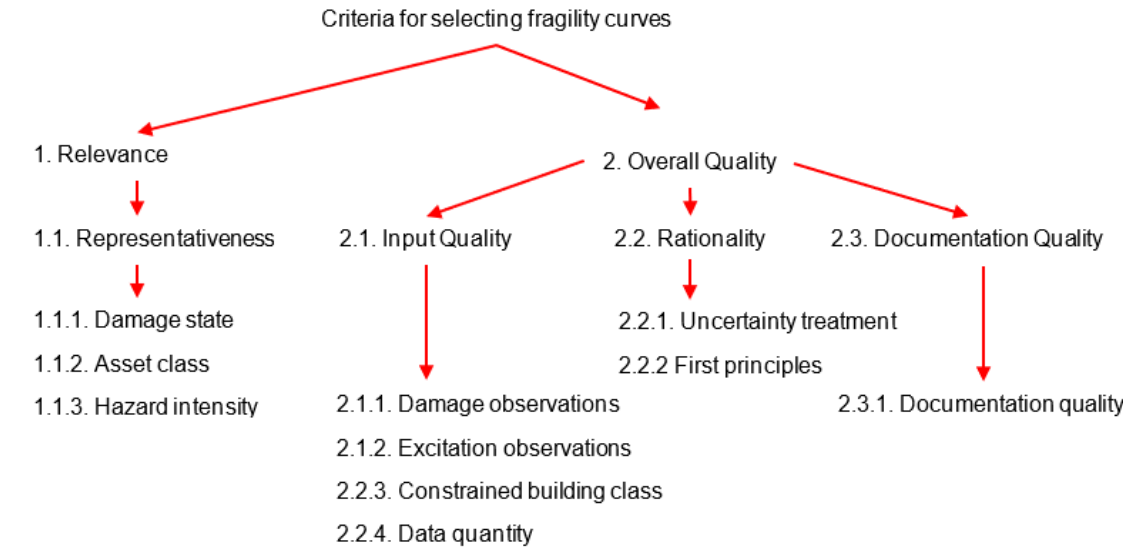
Figure 14. Criteria for selecting fragility functions, after Rossetto et al. [118]; Cartes et al. [117].